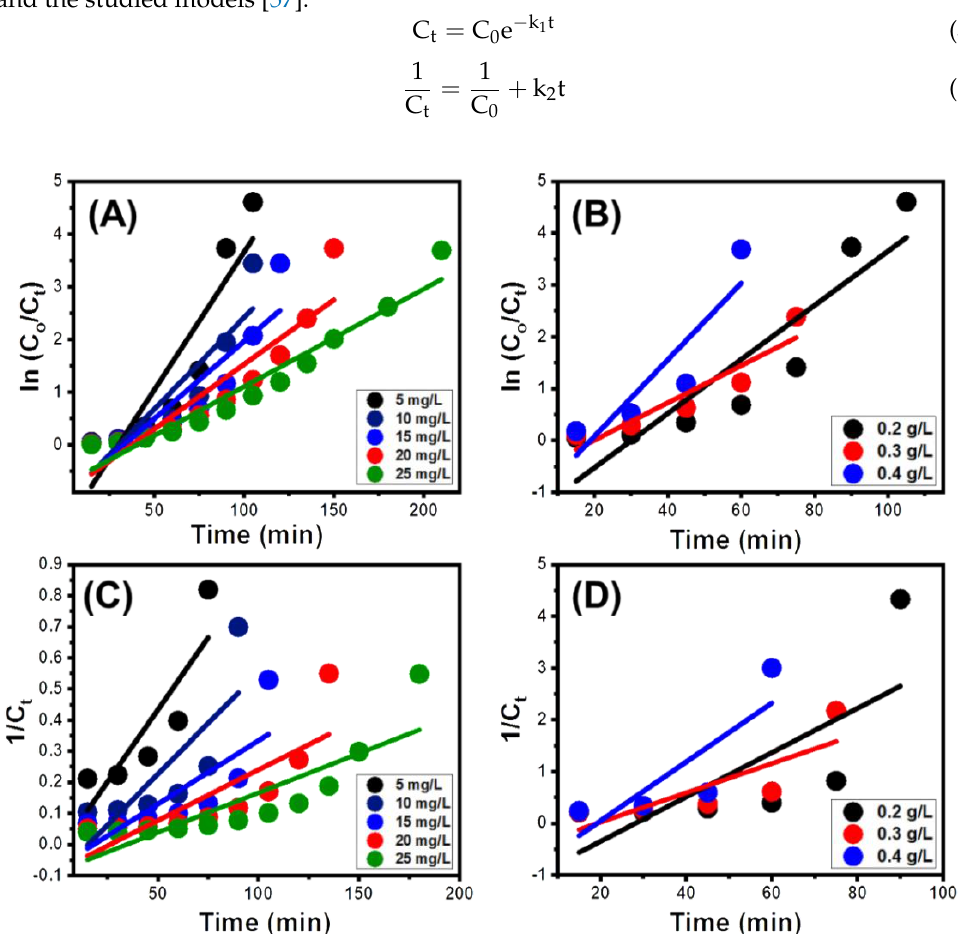
Figure 7. Fitting of the C.R photo – Fenton ’ s oxidation results using MG/CFC with First order ( A , B ) and Second order ( C , D ) kinetic